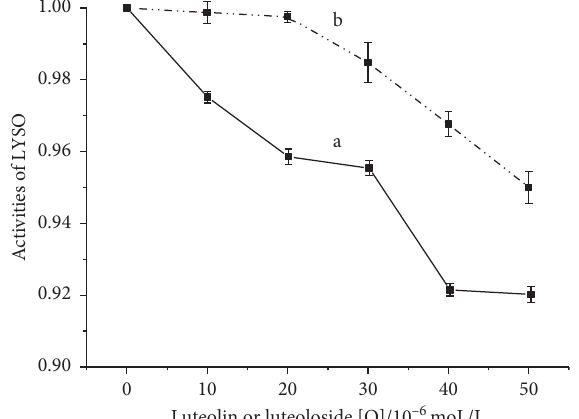
Figure 7: The activities of LYSO at different concentrations of luteolin or luteoloside. (a) luteolin-LYSO and (b)